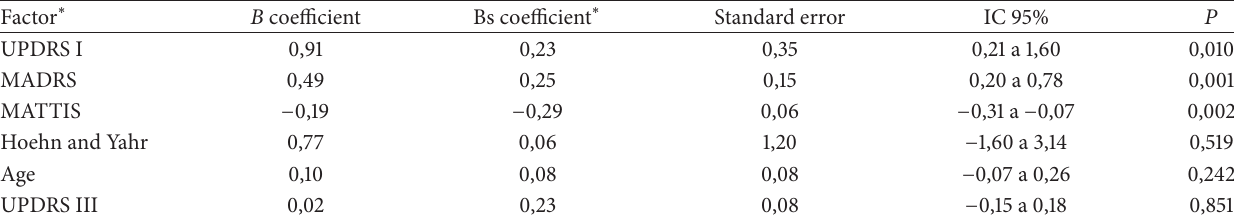
Table 5: Multiple regression